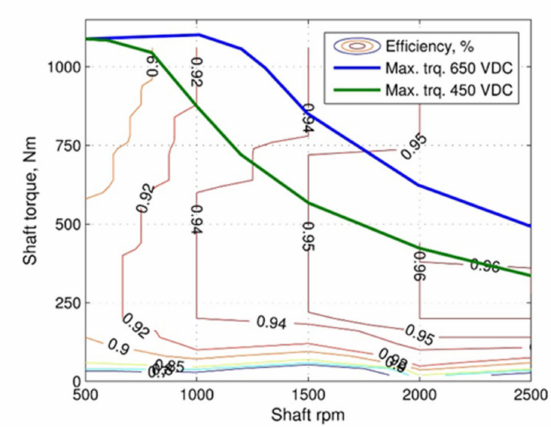
Figure 5. E ffi ciency map and torque characteristics of the electric drive (motor mode).